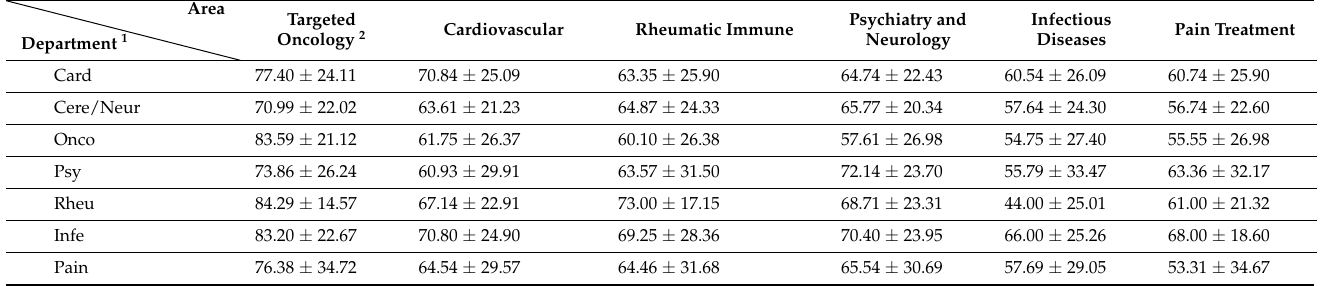
Table 3. Scores of clinical pharmacists from different departments on the value of pharmacogenomic testing in different therapeutic areas (the most relevant departments to the disease areas were